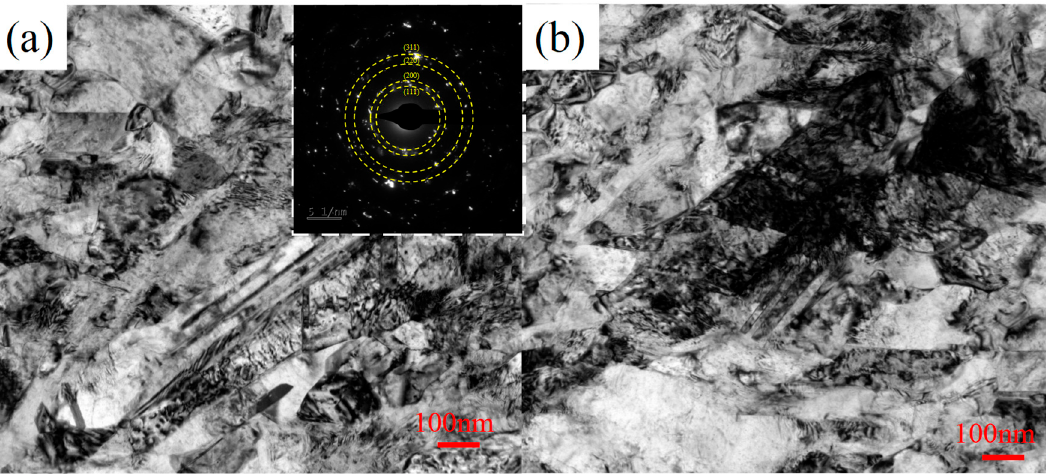
Figure 4. Electrodeposition Ni lattice TEM information: ( a ) brightfield image of microstructure and micro-diffraction spots; ( b ) twins images.